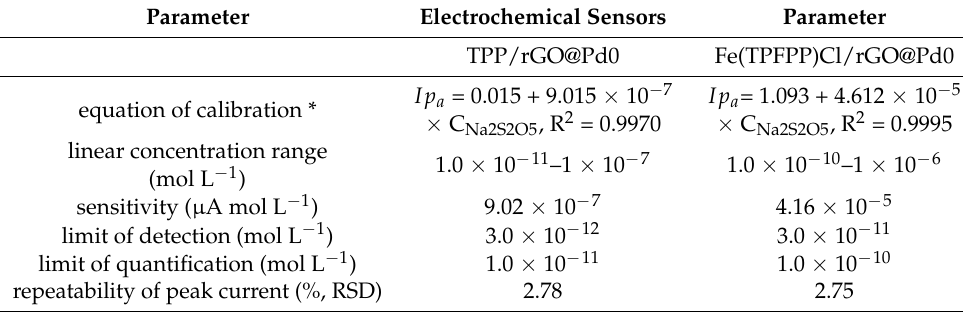
Table 1. Response characteristics of the electrochemical sensors used for detection of sodium